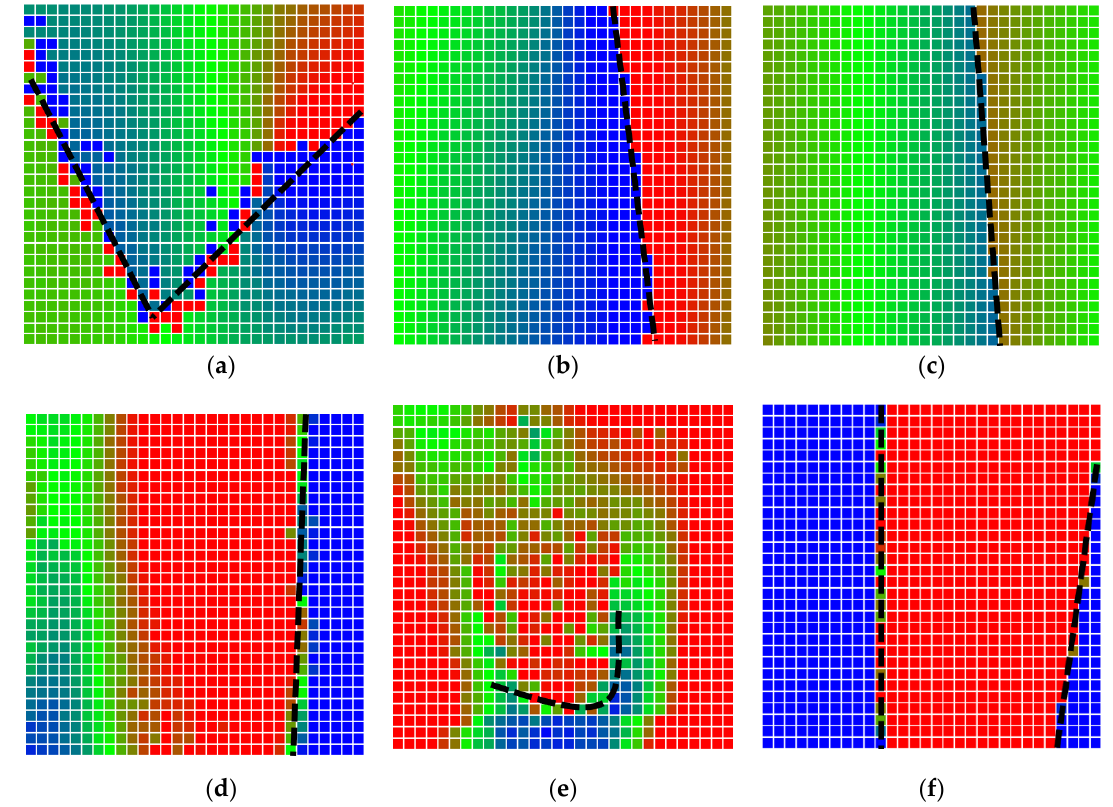
Figure 8. The black lines depict step boundaries; when the tag moves across this line, a sudden change in the detected tag orientation is observed. Observations for ( a ) Roll; ( b ) Pitch; ( c ) Yaw; ( d ) X; ( e ) Y; ( f ) Z.